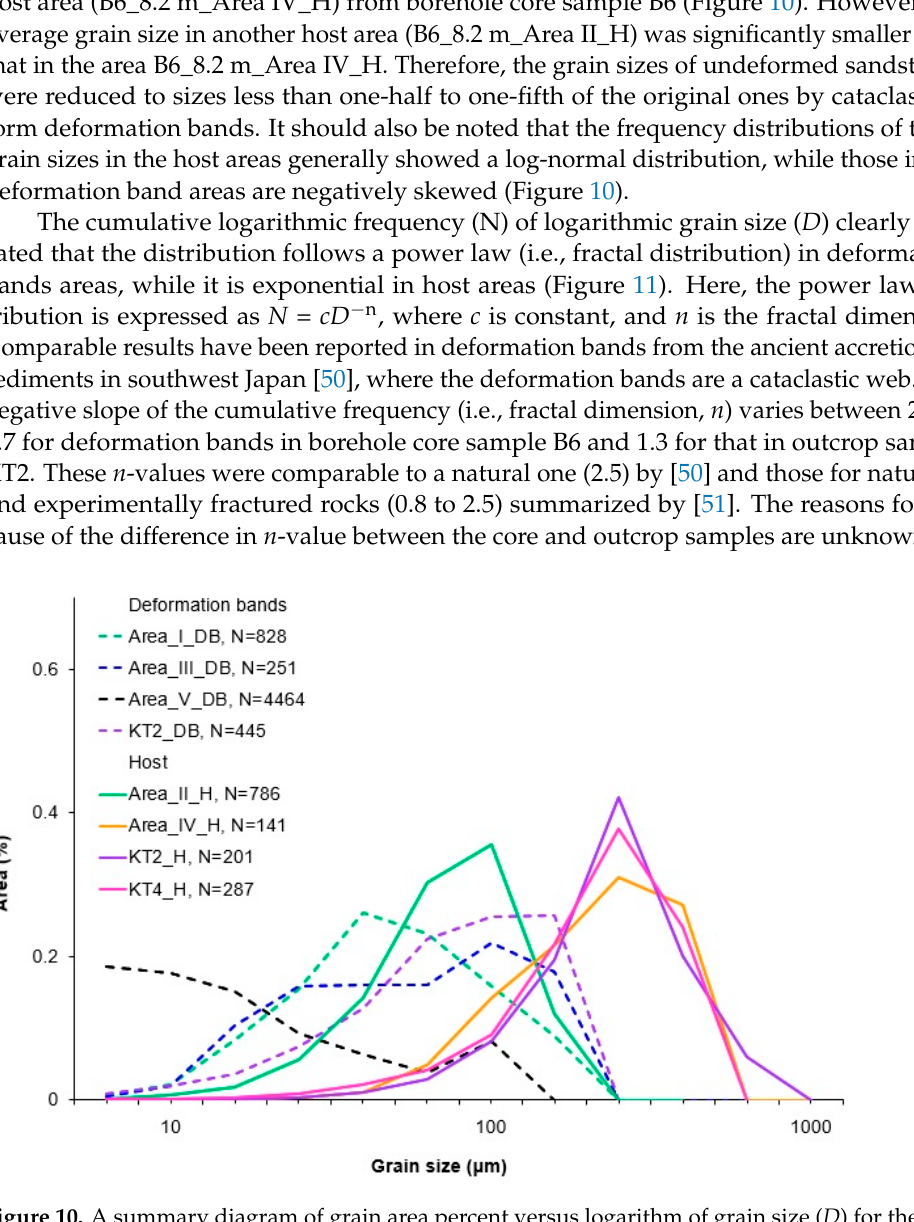
Figure 10. A summary diagram of grain area percent versus logarithm of grain size ( D ) for the four deformation band areas and four host areas in the core and outcrop samples. N is the number of grains analyzed.